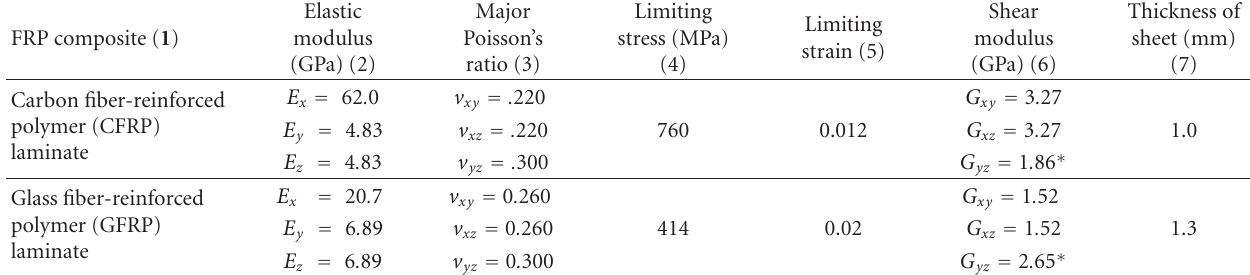
Table 2: Summary of material properties for FRP composites [9].